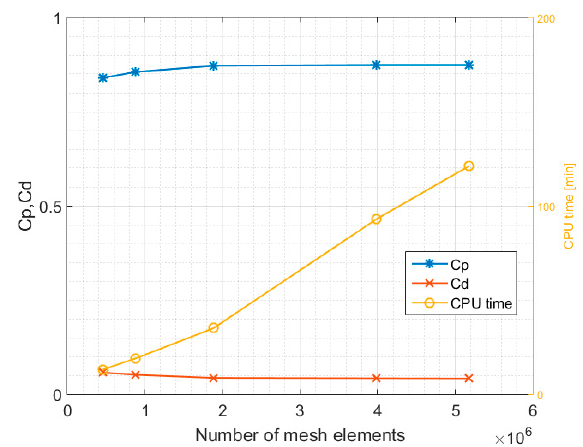
Figure 3. Mesh independency analysis for the draft tube. Table 1. Details of the grids used in the subdomains.